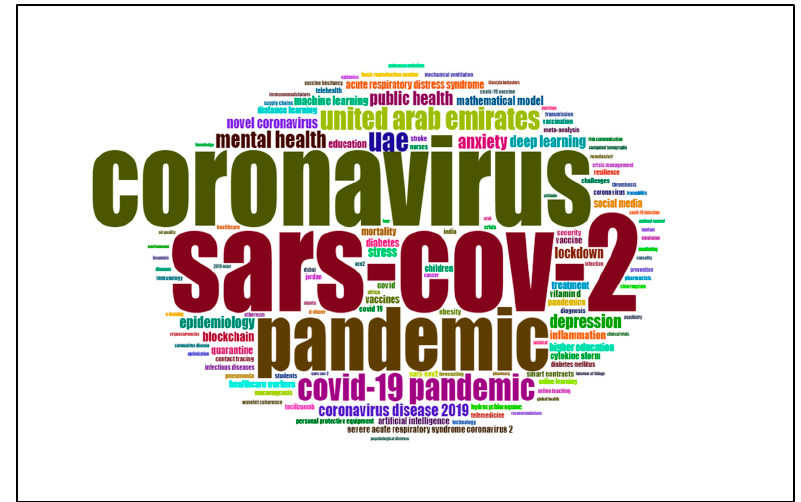
Figure 7. The author keywords WordCloud mapping.